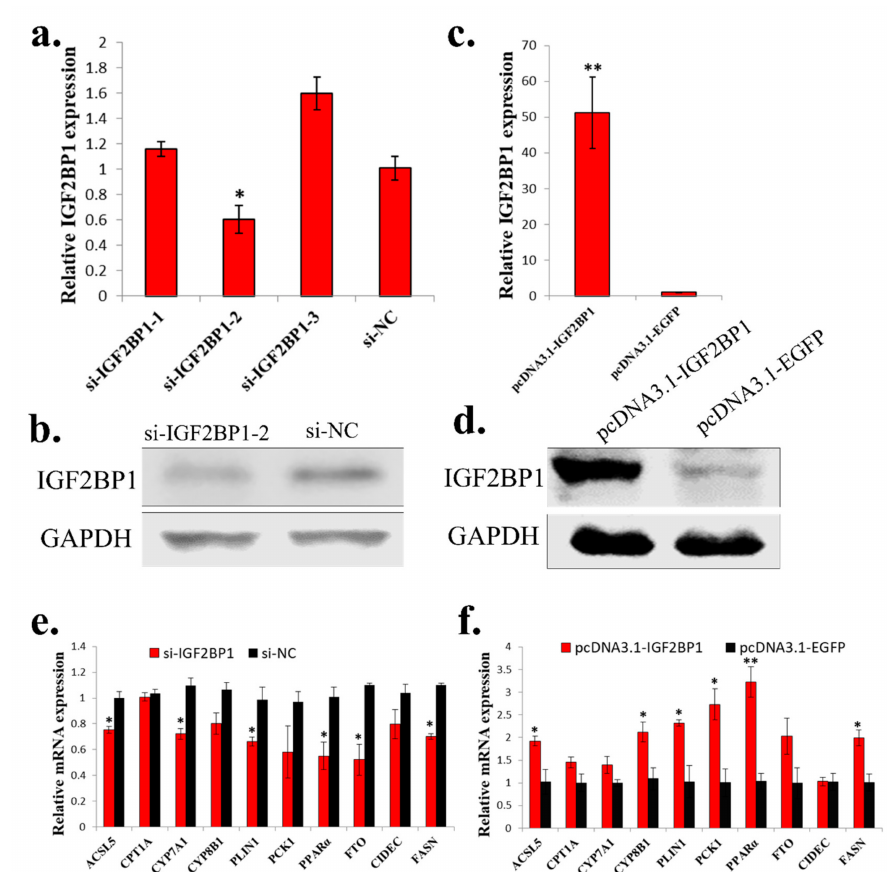
Figure 4. IGF2BP1 promotes the expression of genes involved in fatty acid metabolism in LMH cell. ( a ) The mRNA expression of IGF2BP1 after 48 h transfection of si-IGF2BP1 in LMH cell. ( b ) The protein expression of IGF2BP1 after 48 h transfection of si-IGF2BP1 in LMH cell. ( c ) The mRNA expression of IGF2BP1 after 48 h transfection of IGF2BP1 overexpression vector in LMH cell. ( d ) The protein expression of IGF2BP1 after 48 h transfection of IGF2BP1 overexpression vector in LMH cell. ( e ) The expression of genes related to fatter acid metabolism after transfection of si-IGF2BP1 in LMH cell. ( f ) The expression of genes related to fatter acid metabolism after transfection of pcDNA3.1-IGF2BP1 in LMH cell. The data are mean ± S.E.M. with four samples ( n = 4 / treatment group). Independent sample t test was used to analyze the statistical di ff erences between groups. * p < 0.05; ** p <